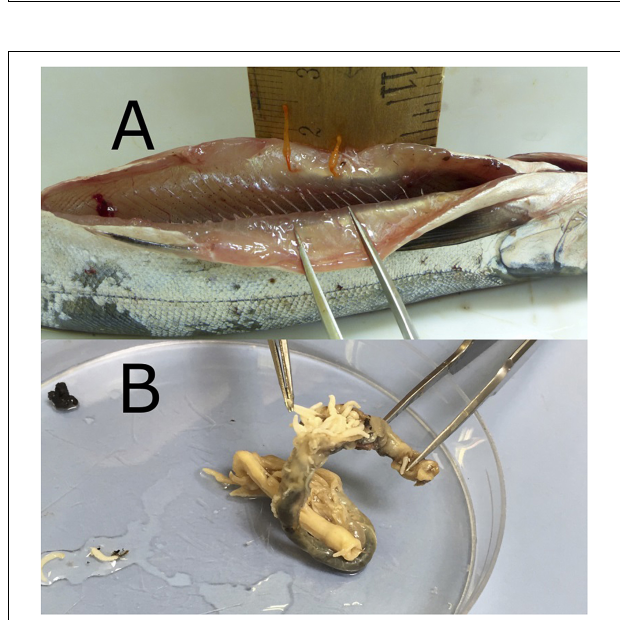
FIGURE 2 | (A) Photograph of P. tereticollis outside the alimentary tract of salmon smolt and attached to the peritoneum and muscle wall. (B) Salmon smolt intestine, heavily infected by P. tereticollis